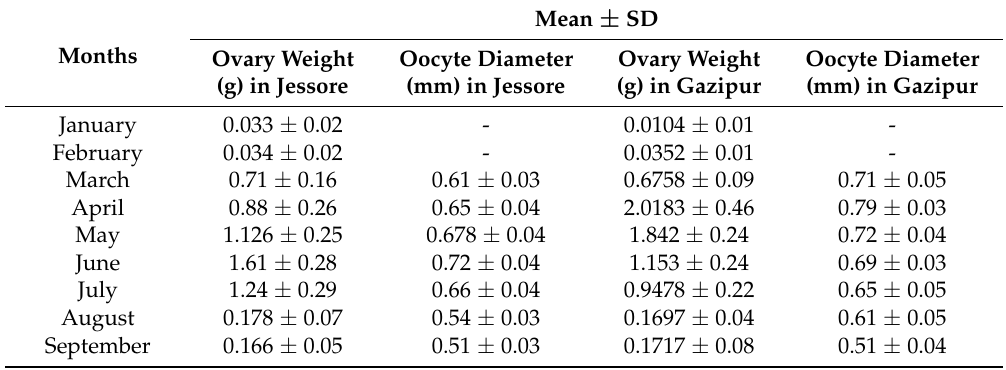
Table 4. Mean and standard deviation ( ± SD) of ovary weight (g) and oocyte diameter (mm) of P. sophore. Mean ± SD Months Ovary Weight Oocyte Diameter Ovary Weight Oocyte Diameter (g) in Jessore (mm) in Jessore (g) in Gazipur (mm) in Gazipur January 0.033 ±